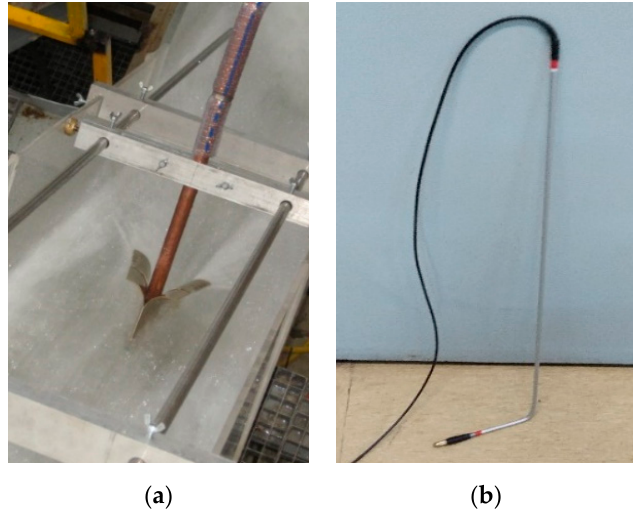
Figure 5. Velocity and concentration data collection: ( a ) Pitot probe during the velocity measurement process; ( b ) view of the Air Concentration Meter probe used in the concentration measurement process.